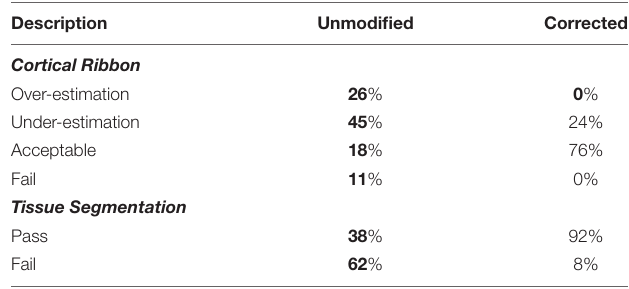
TABLE 2 | Quality control results for FreeSurfer Unmodified and Corrected